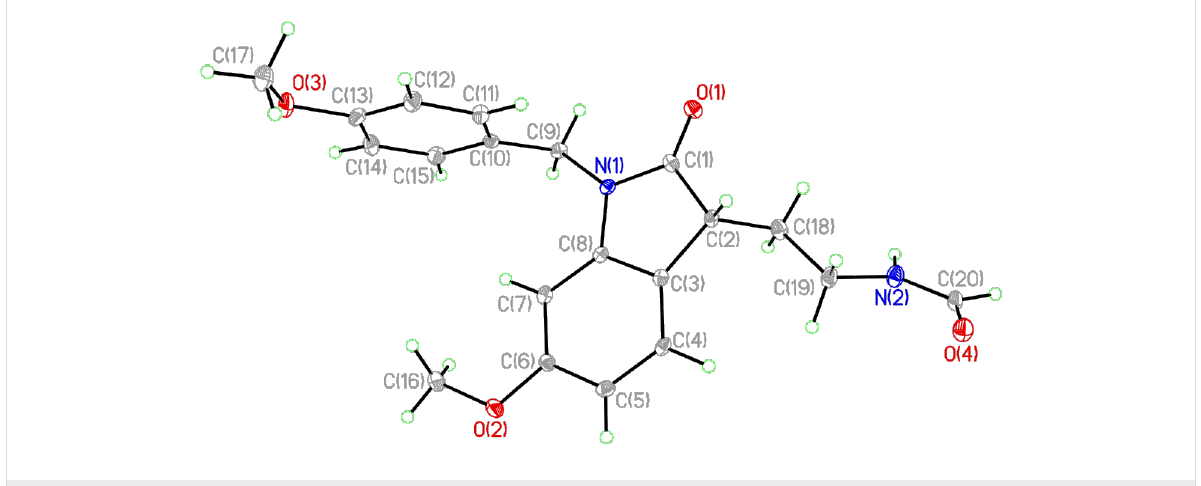
Scheme 3: Synthesis and cyclization of precursors 22 – 24 .